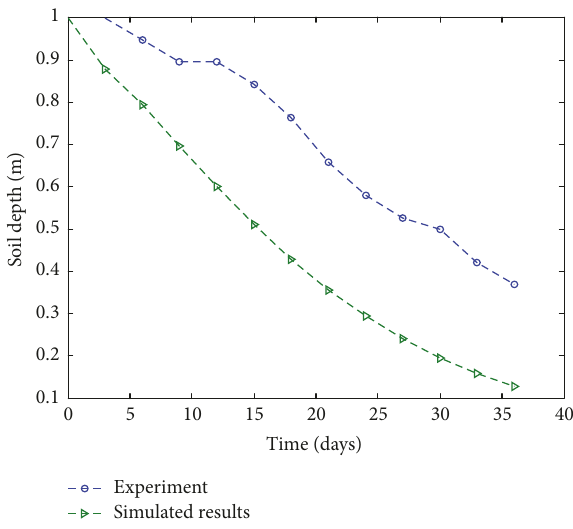
Figure 3: Comparative analysis of experimental and simulated results.